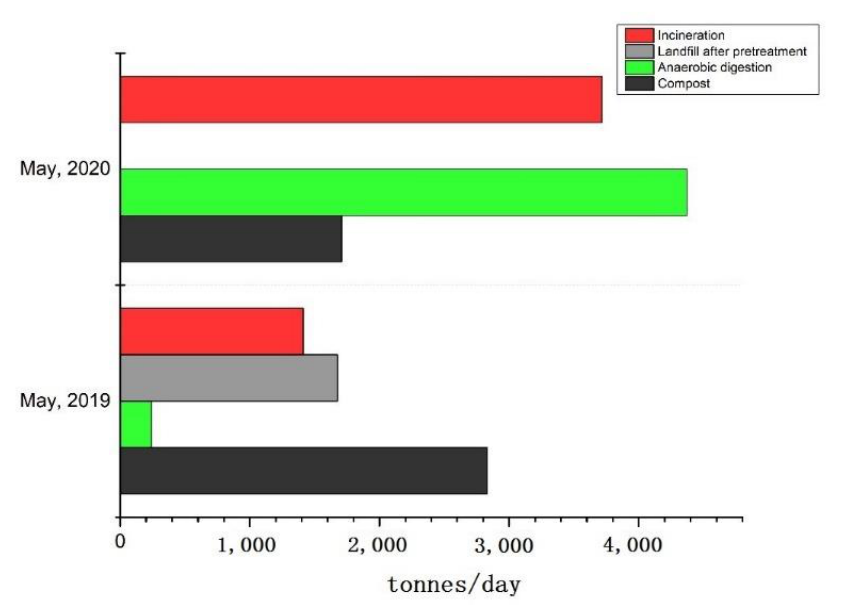
Figure 4. The proportion of different disposal treatments for food waste in Shanghai before and after the July 2019 law [31]. Note the great increase in AD (possible only because of the lower contamination levels achieved), and consequent elimination of landfill. Composting facilities were reduced due to previous issues with odors.